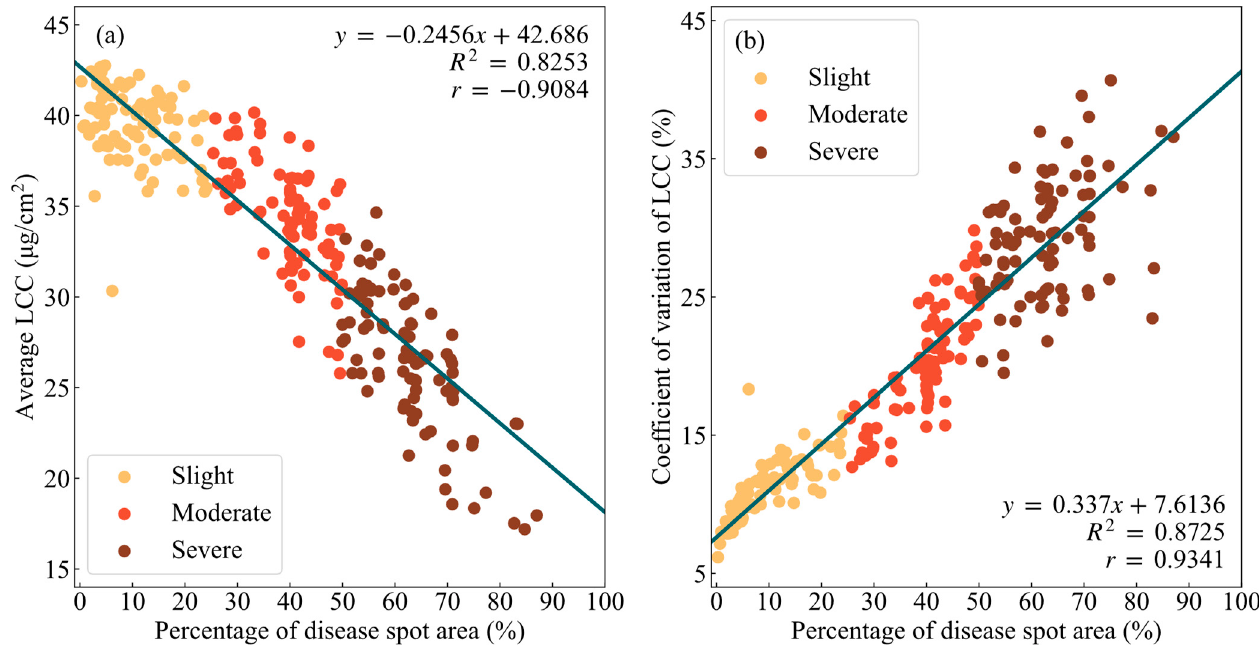
Figure 8. Correlation of ( a ) average LCC and ( b ) CV of LCC with disease spot